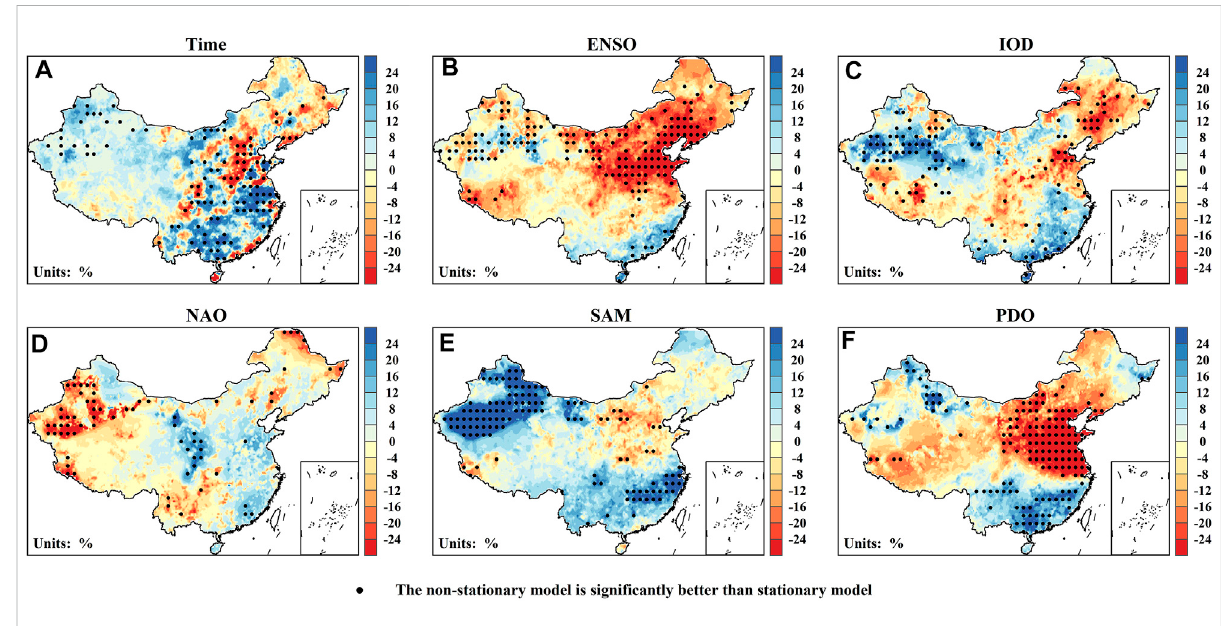
FIGURE 6 The same as Figure 5 but for the non-stationary GP